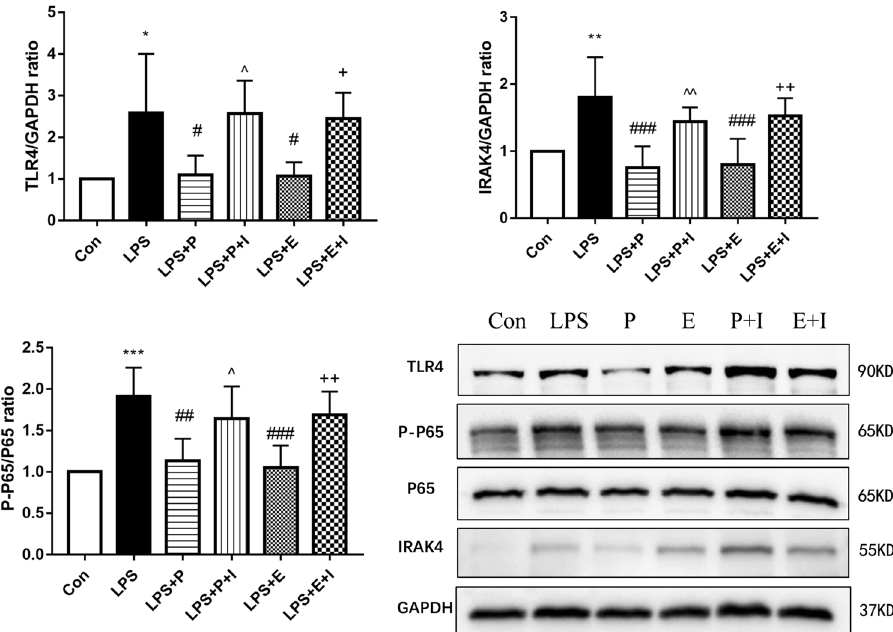
Figure 9. Effects of psoralen on the expression of TLR4, IRAK4, p65 and p-p65 protein. hPDLCs were divided into 6 groups: Con, control group; LPS, LPS (1 μg/mL) group; LPS + E, LPS and estrogen (10 −8 M) group; LPS + P, LPS and psoralen (12.5 μg/mL) group; LPS + E + I, LPS and estrogen (10 −8 M) and ICI (1 μM) group; LPS + P + I, LPS and psoralen (12.5 μg/mL) and ICI (1 μM) group (* p < 0.05,** p < 0.01, *** p < 0.001 compared with the control group, # p < 0.05, ## p < 0.01, ### p < 0.001 compared with the LPS group, ^ p < 0.05, ^^ p <